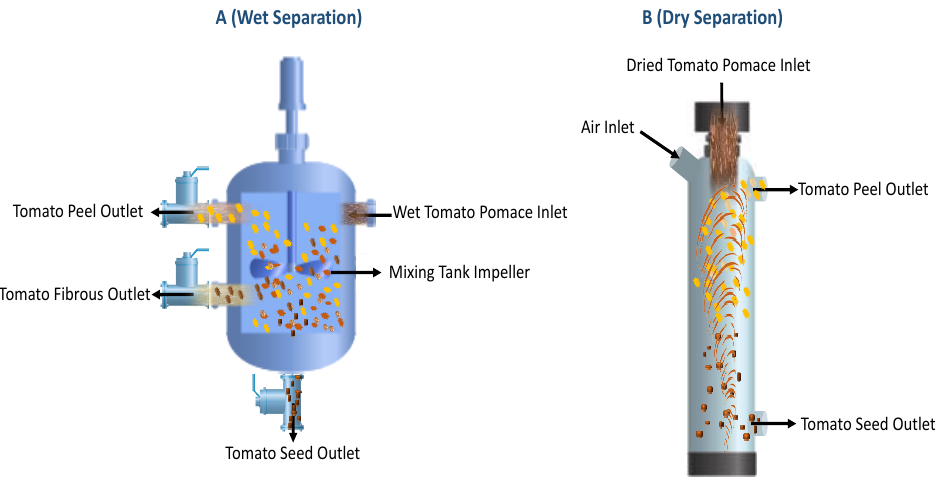
Figure 3. Schematization of wet ( A ) and dry ( B ) methods for tomato peel and seed separation. 4. Recovery of High-Added-Value Compounds from Tomato Processing By-Products by Conventional